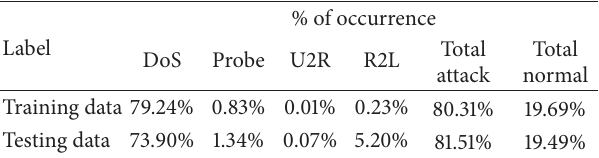
Table 1: Distribution of connection types in 10% KDDCup’99 data- set.